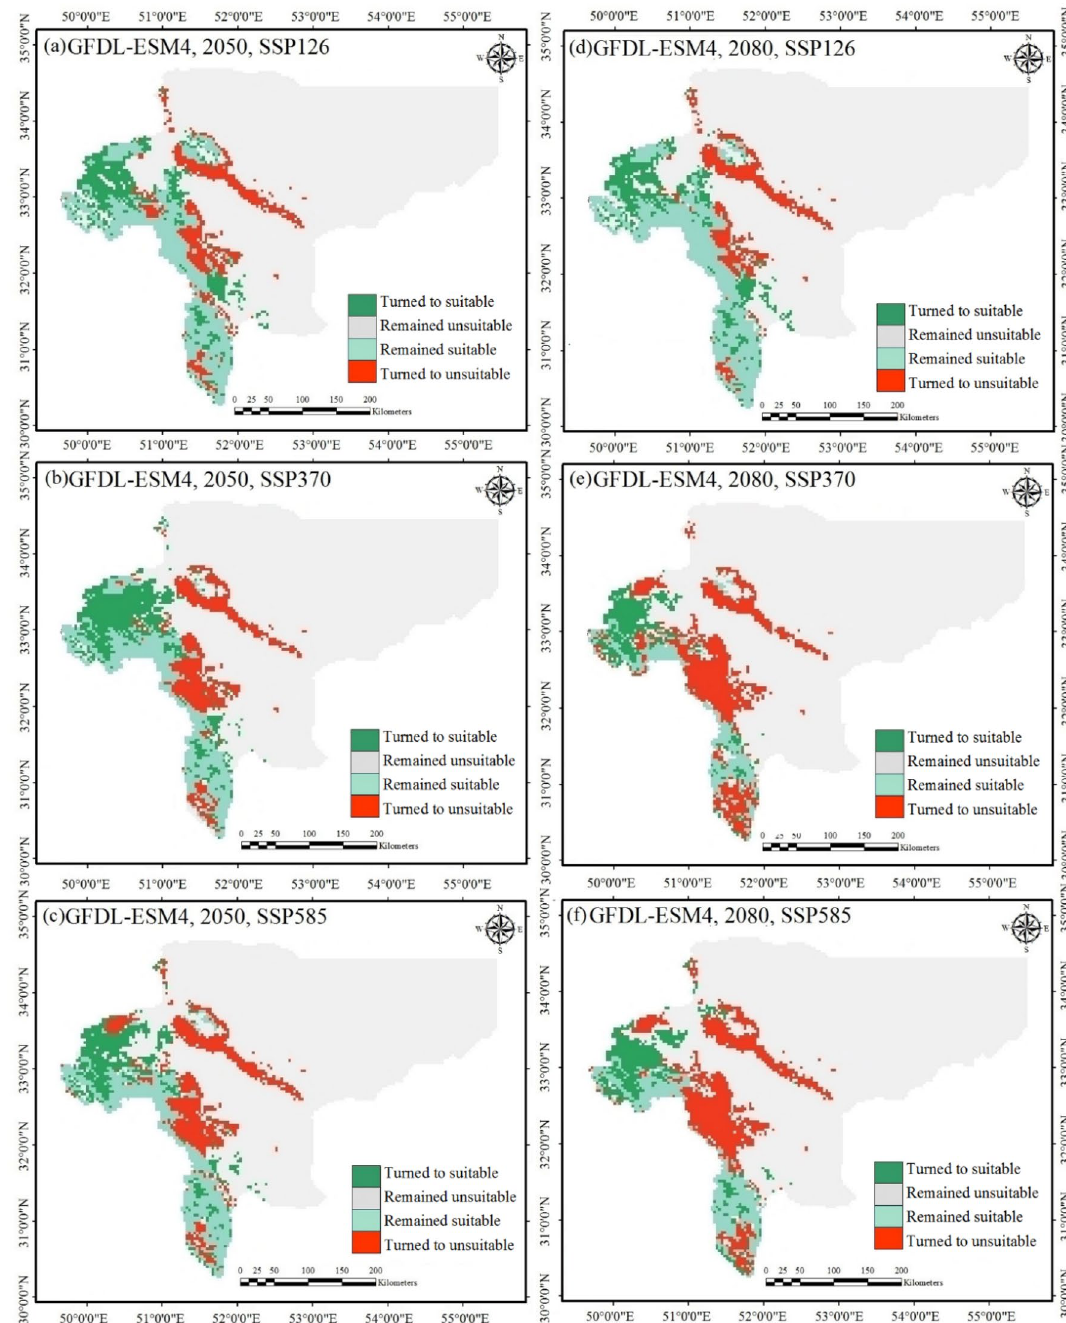
Figure 6. Changes in the suitable habitat distribution for S. inflata under current and the climates of 2050 ( a – c ) and 2080 ( d – f ) under the first GCM. Each part displays a different year and emissions